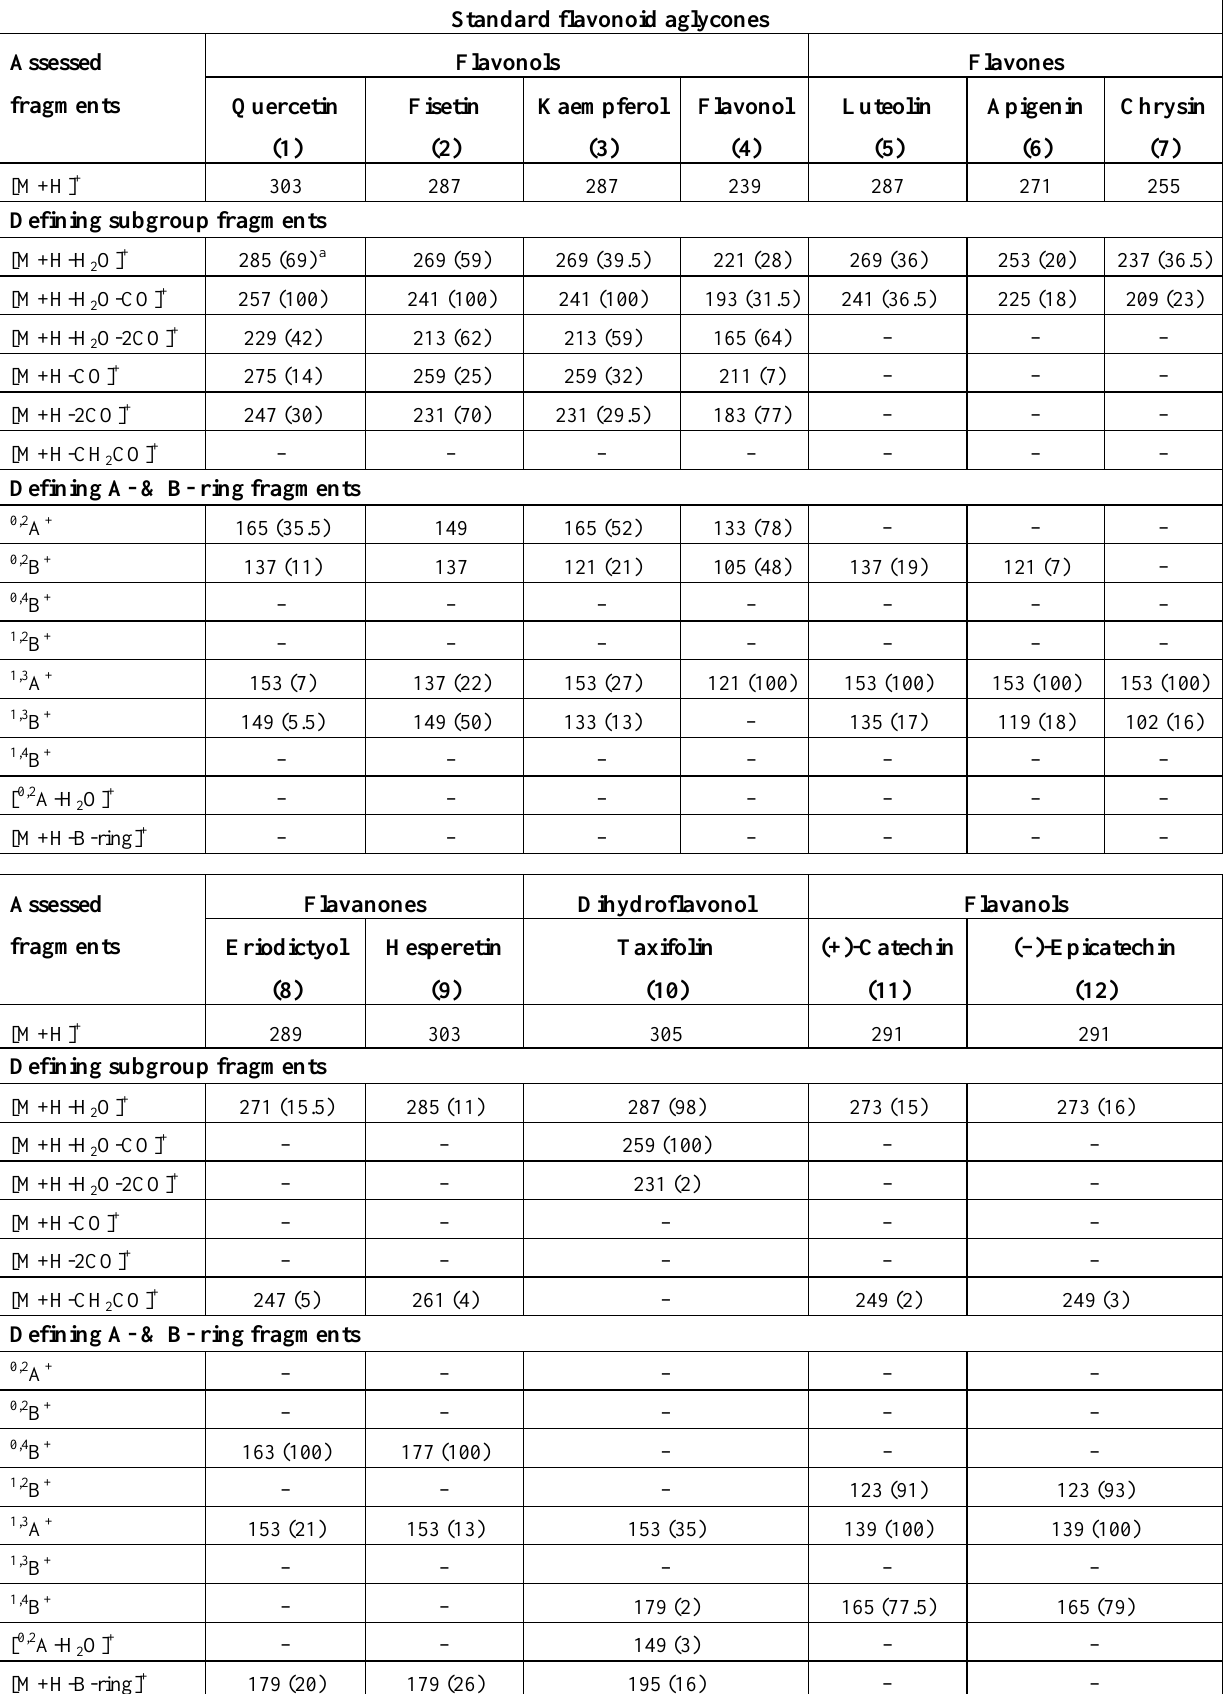
Table 2. The [M+H] + molecules of the standard flavonoid aglycones, as well as the defining structure fragments produced by MS 2